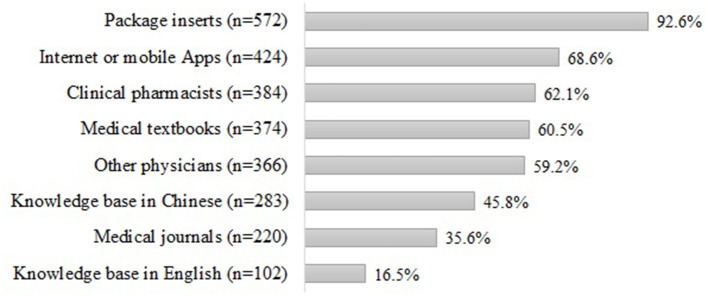
Source of information for PDDIsa. aSum may not be 100% because respondents were allowed to choose multiple answers.